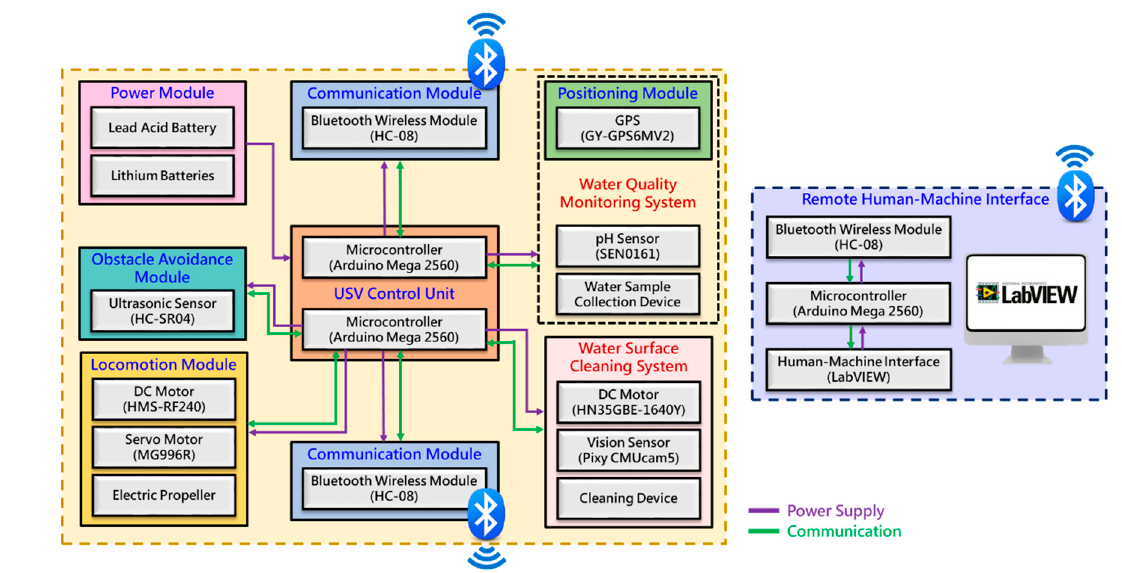
Figure 2. System architecture of the MF-USV. Table 2. Components of the MF-USV with their weight and power consumption.